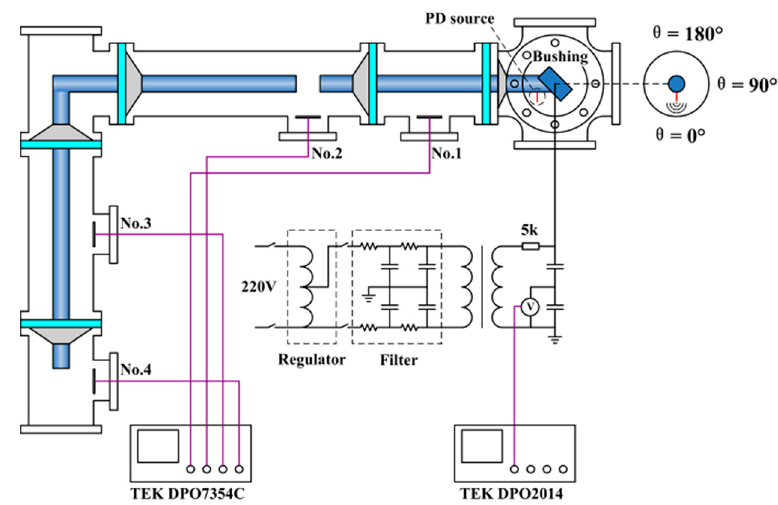
Figure 3. Experimental setup.